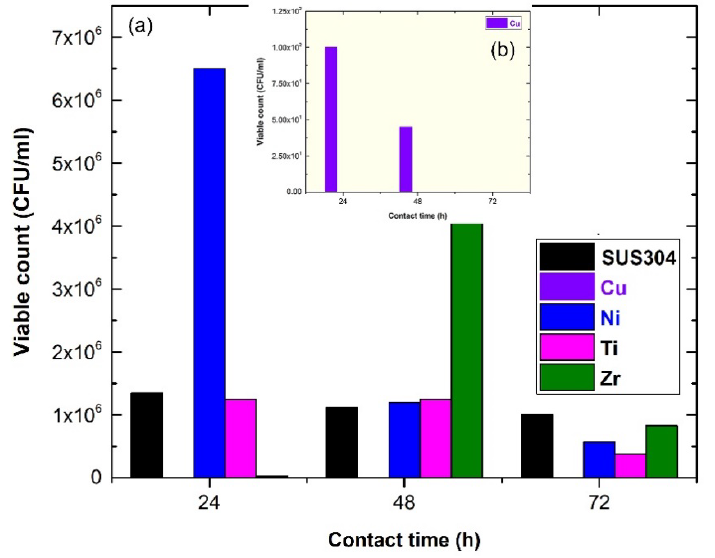
Figure 4. Inhibition of biofilm adhesion on ( a ) pure powder elemental alloy (Cu, Ni, Ti, Zr) and uncoated SUS304 coupons ( b ) inhibitory effect of Cu.